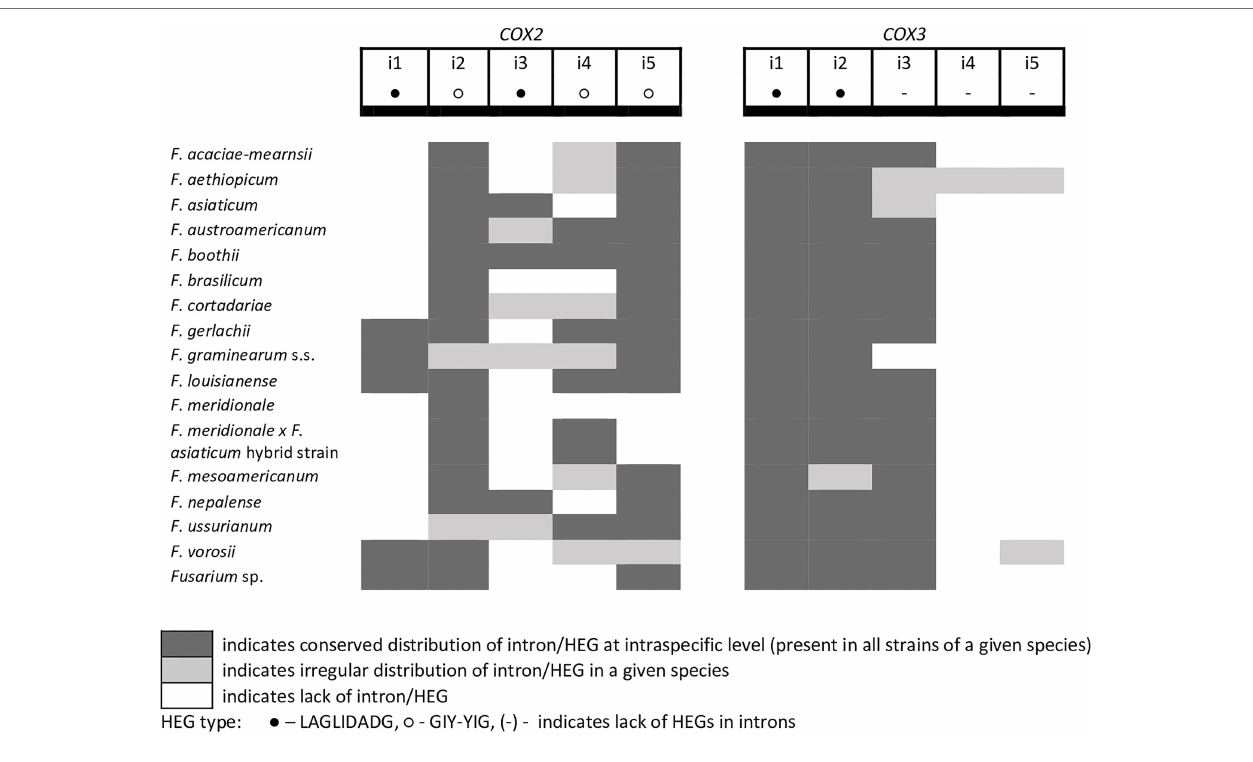
FIGURE 4 | Distribution of introns and associated HEGs found in the COX2 and COX3 genes.